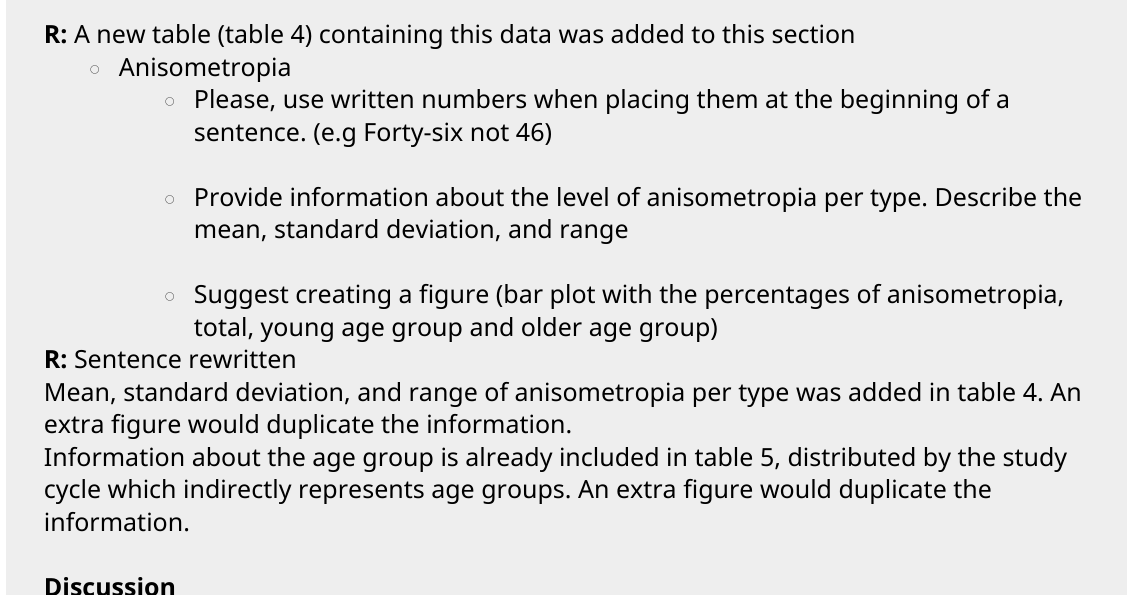
R: A new table (table 4) containing this data was added to this section